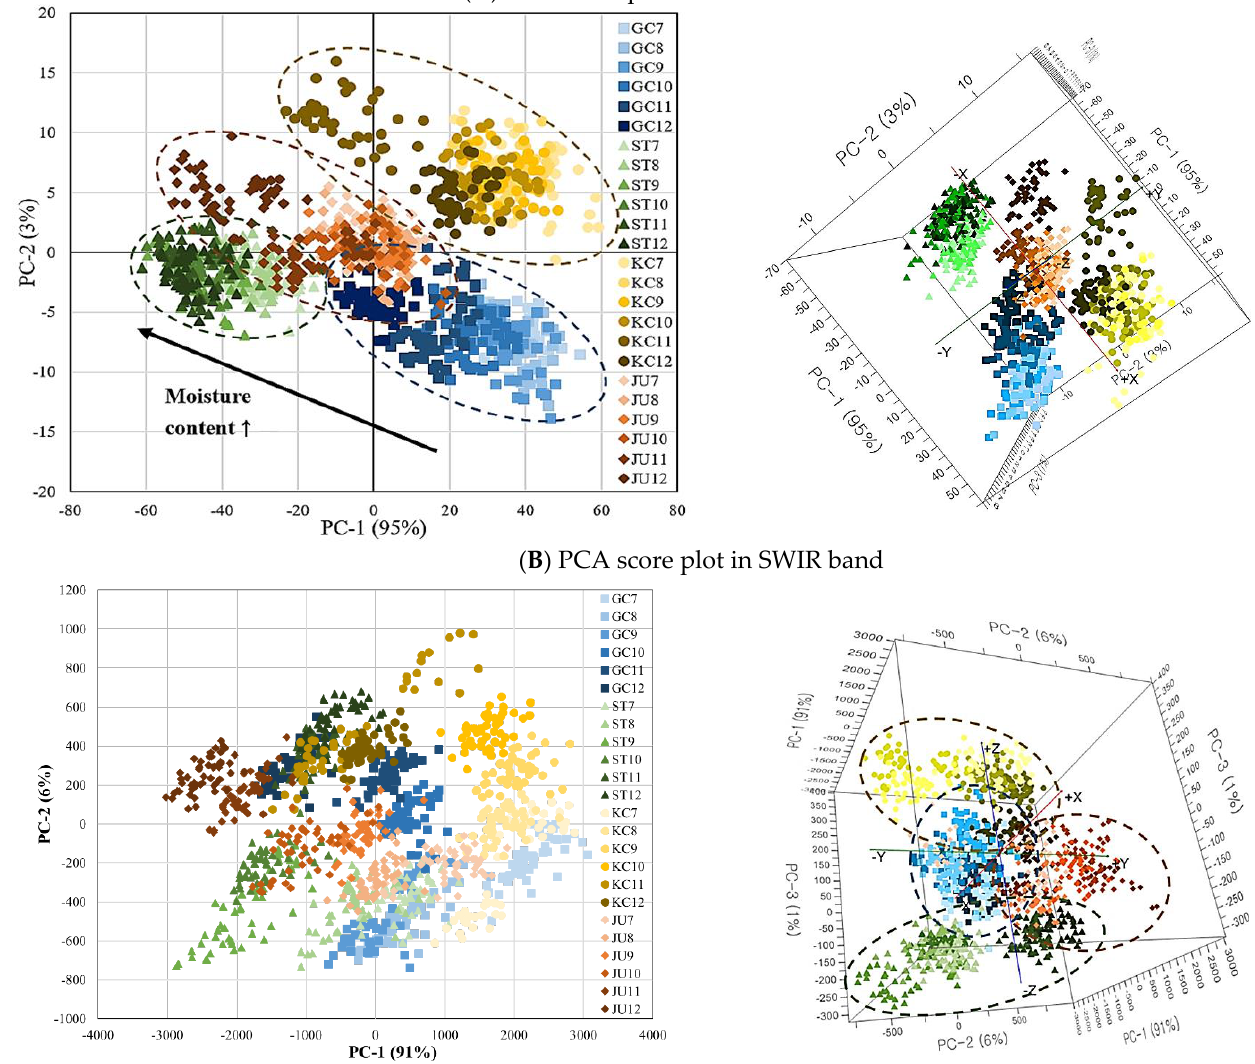
Figure 3. PCA score plot of hyperspectral spectra in the VIS − NIR ( A ) and SWIR band ( B ).